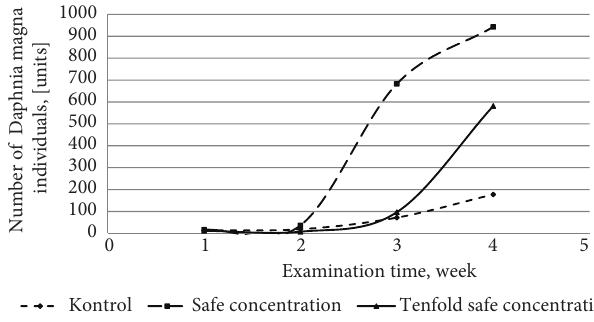
Figure 4. Dynamics of changing the number of Daphnia magna Straus in microcosm